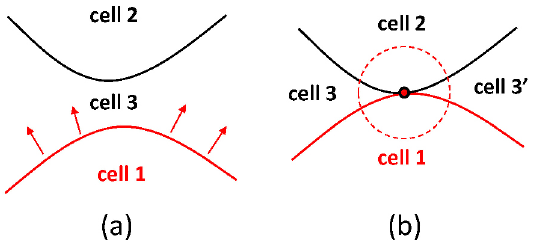
Fig. 11 Topology changes at cell edges during expansion. This situation only exists for non-convex inputs, and not for circle and ellipse inputs.